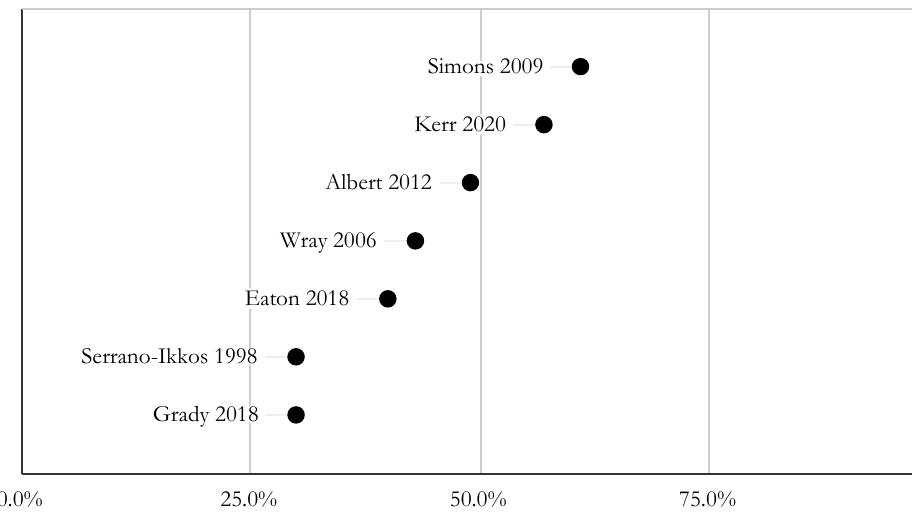
Figure 2. Reported non-adherence rates. Table 2. Measures of Adherence.